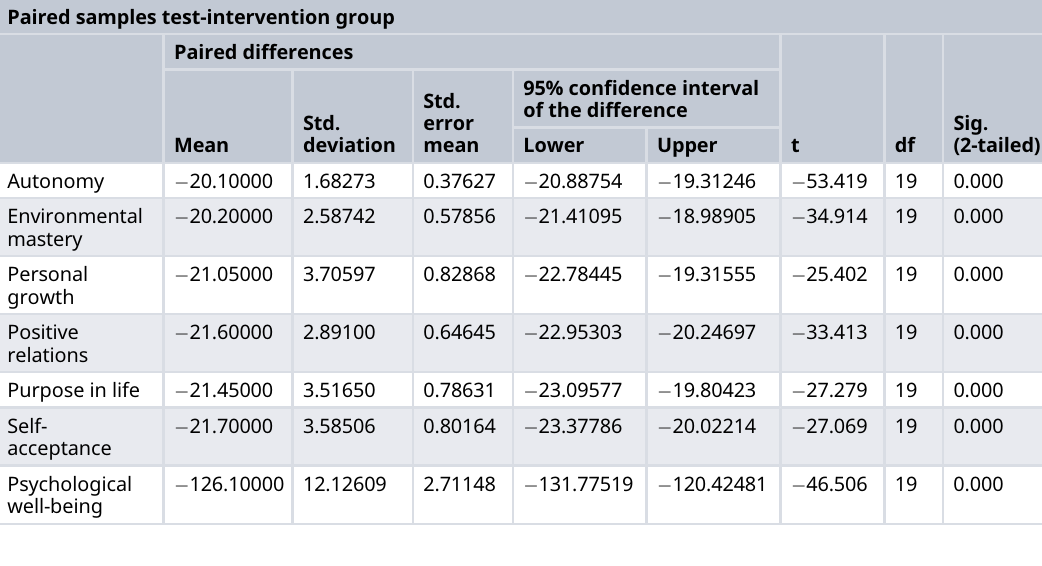
Paired samples test-intervention group